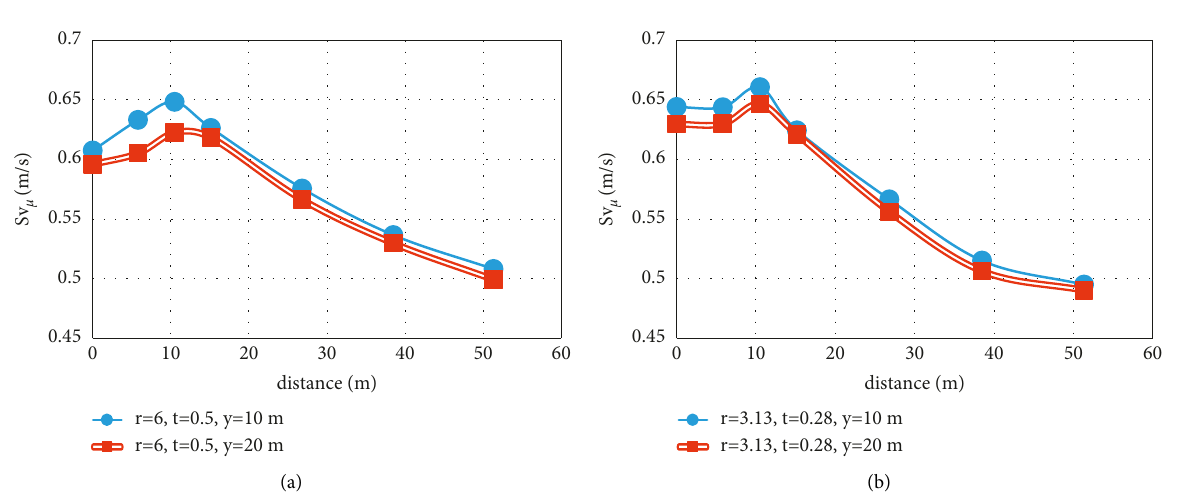
Figure 13: The effect of change in overburden depth on ground surface velocity for models (a) 28 and 29 and (b) 31 and 34 of Table 1.